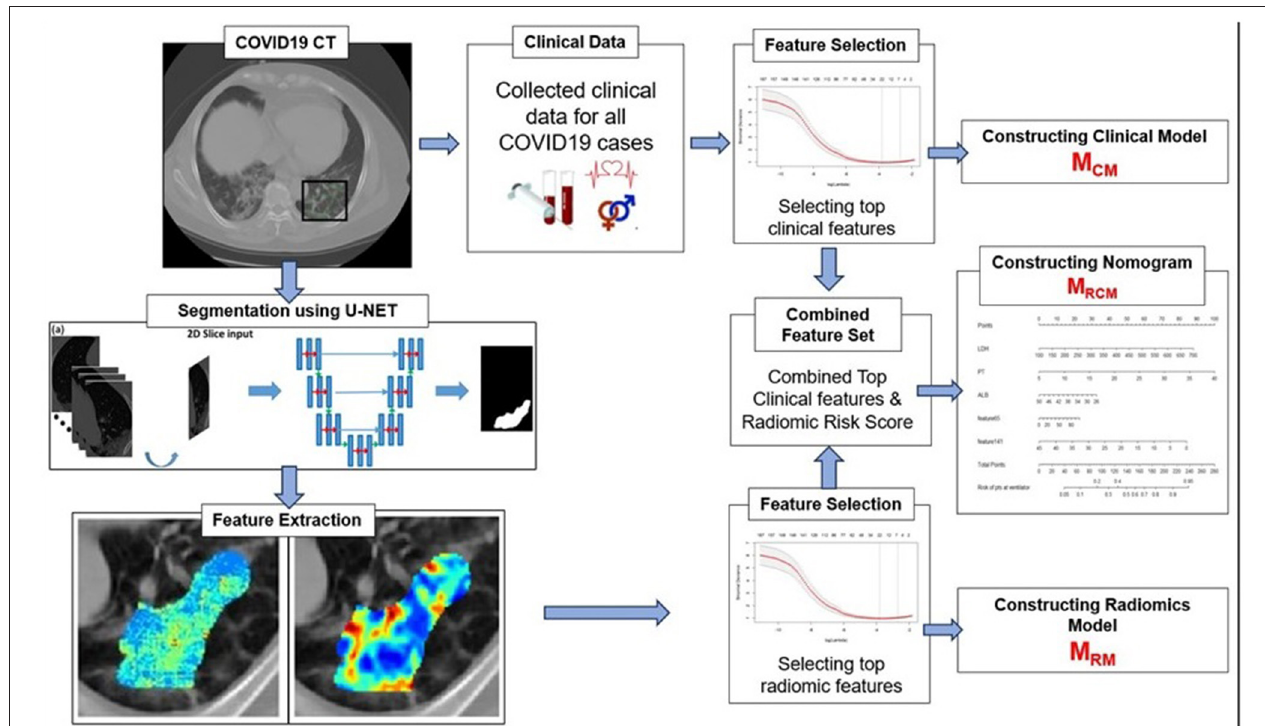
FIGURE 2 | Workflow of the experiment. The first step involves segmentation of coronavirus disease (COVID) consolidations, which were further used for radiomic feature extractions. Next, the top clinical and radiomic features were selected using (LASSO) analysis and further used for constructing radiomic model (M RM ), clinical model (M CM ), and combined combined clinical–radiomic (MRCM) nomogram.